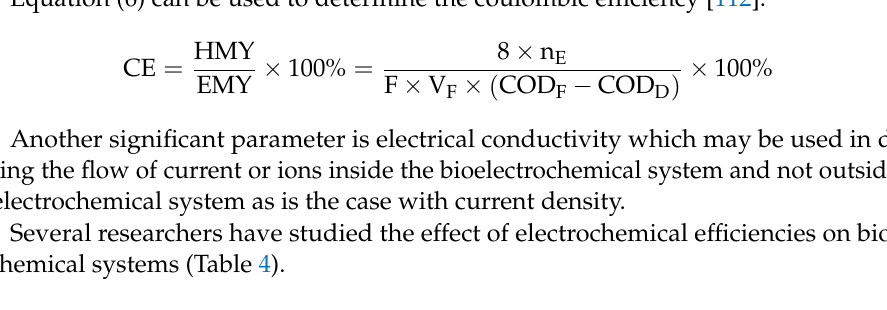
Table 4. Previous studies on electrochemical efficiencies. Effect of Electrochemical Efficiencies Type of Bioelectrochemical System